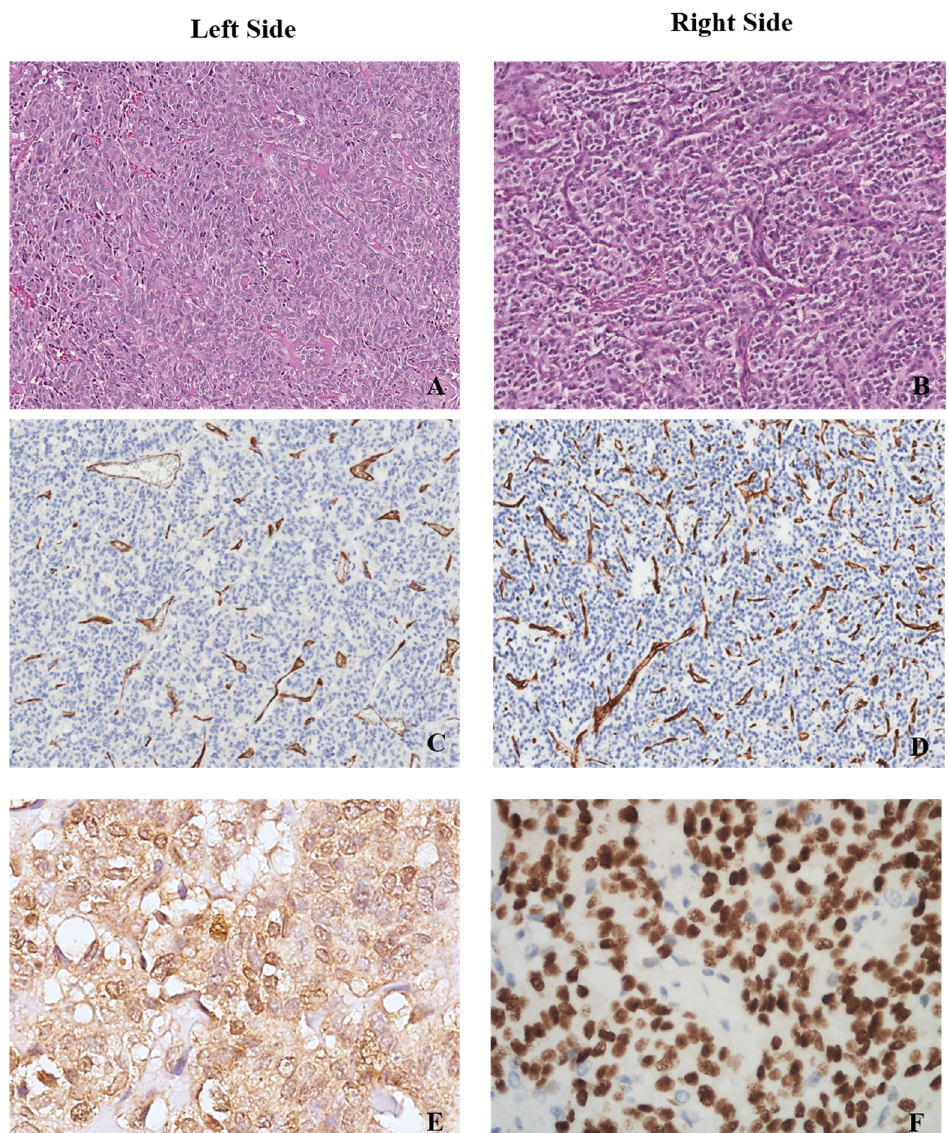
Figure 1. Primary lung carcinoid. ( A ) Right-sided lesion ( B,D ) showing a higher density in intra- tumoural vessels when compared to a left-sided case ( A,C ). ( A,B) Haematoxylin and eosin stain, 10 ×, and ( C, D) CD34 immunohistochemical stain for endothelial cells, 10 ×. A left-sided lung carcinoid with positivity for HIF-1 α stain ( E ) and a right-sided lung case showing TTF-1 expression ( F ). ( E) HIF-1 α immunohistochemical stain, 40 ×, and ( F ) TTF-1 immunohistochemical stain, 40 ×.